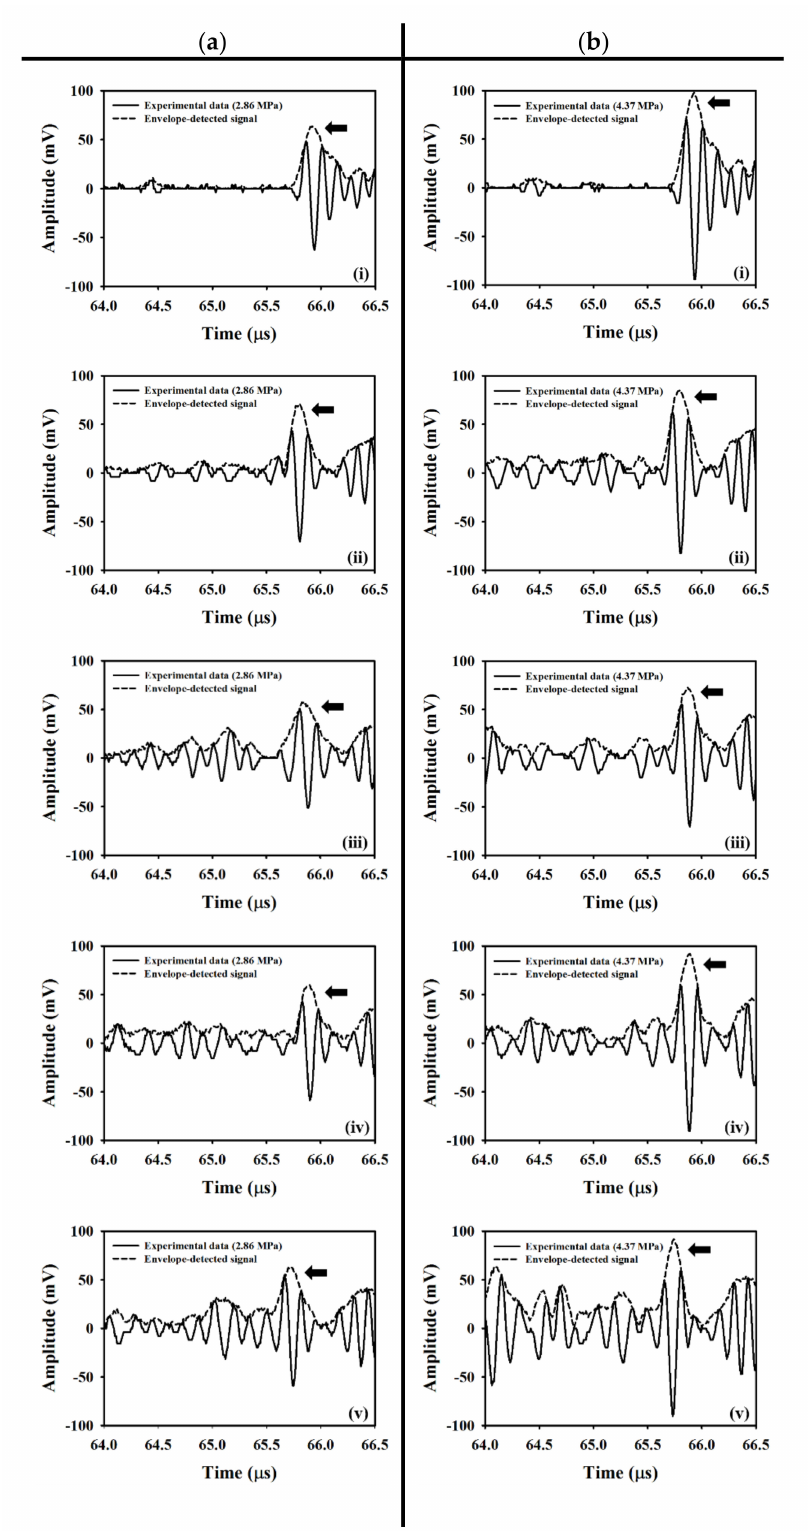
Figure 6. Typical radio-frequency signals and envelopes corresponding to the incidence of ( a ) 2.86 and ( b ) 4.37 MPa acoustic pressures into the flow phantom, where UCAs of various concentrations of (i) 0, (ii) 6.7, (iii) 13.3, (iv) 26.7, and (v) 53.3 × 10 6 UCAs / mL were administered. The black arrow indicates the back wall of the flow